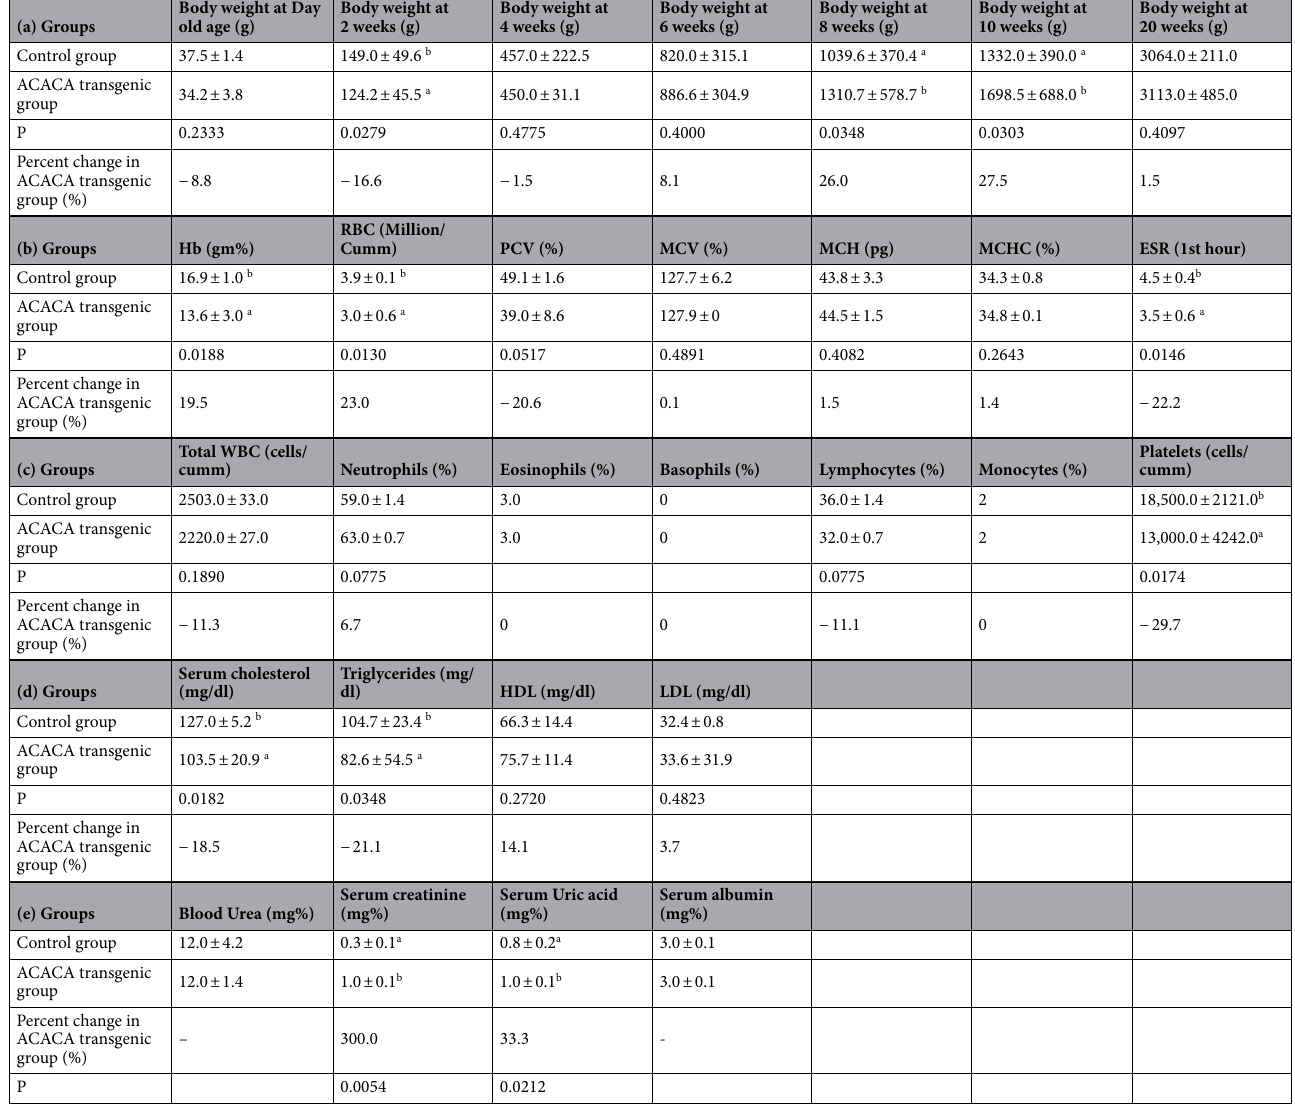
Table 12. Growth performances (a), RBC parameters (b), differential count (c), serum lipids (d) and serum biochemical parameters (e) (Mean ± standard deviation) in transgenic (Values calculated from both 1 male and 1 female birds combinedly) and control birds (Values are on the basis of both 1 male and 1 female birds combinedly) in 2nd generation. Different superscripts (column-wise) indicate significant differences. Significant differences of traits were observed between control and transgenic birds for body weights at 2, 8 and 10 weeks of age; Haemoglobin (Hb) and RBC count; platelets count; serum cholesterol, triglycerides, creatinine and uric